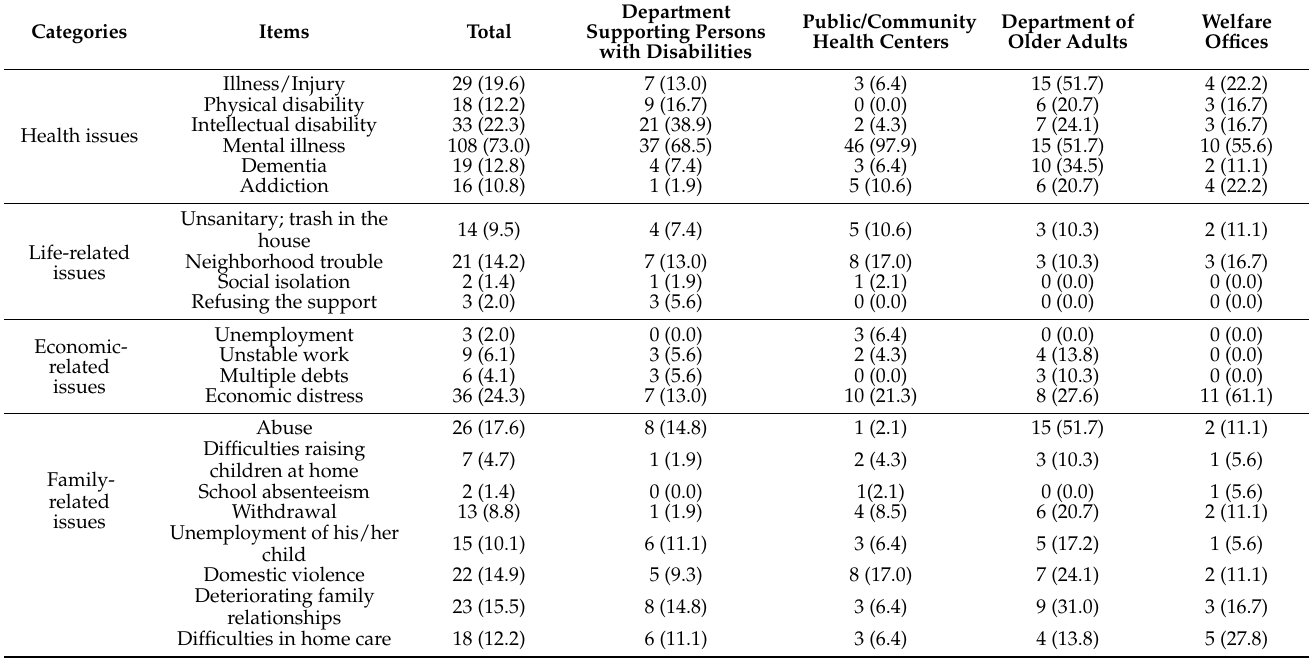
Table 2. The proportion of overlapping health and living-related issues of households supported by each department.